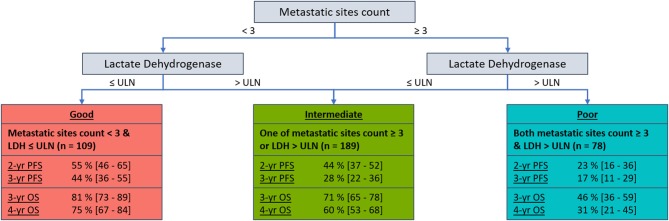
Decision tree with 2 and 3-year PFS, plus 3 and 4-year OS probabilities [95% CI] by pre-treatment prognostic groups for HER2-positive ABC patients who received first-line pertuzumab, trastuzumab, and docetaxel within CLEOPATRA.